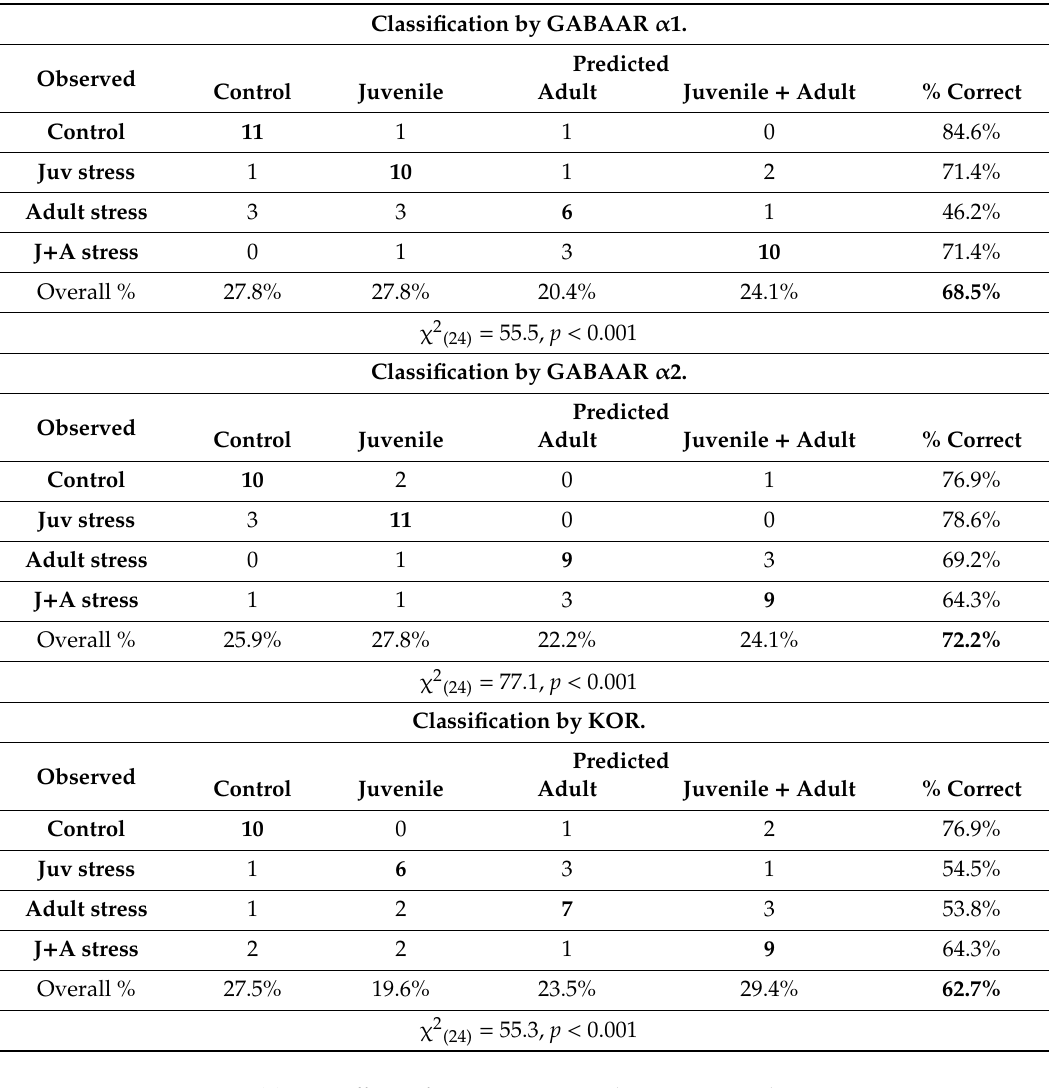
Table A3. E ff ects of receptors type in the separate